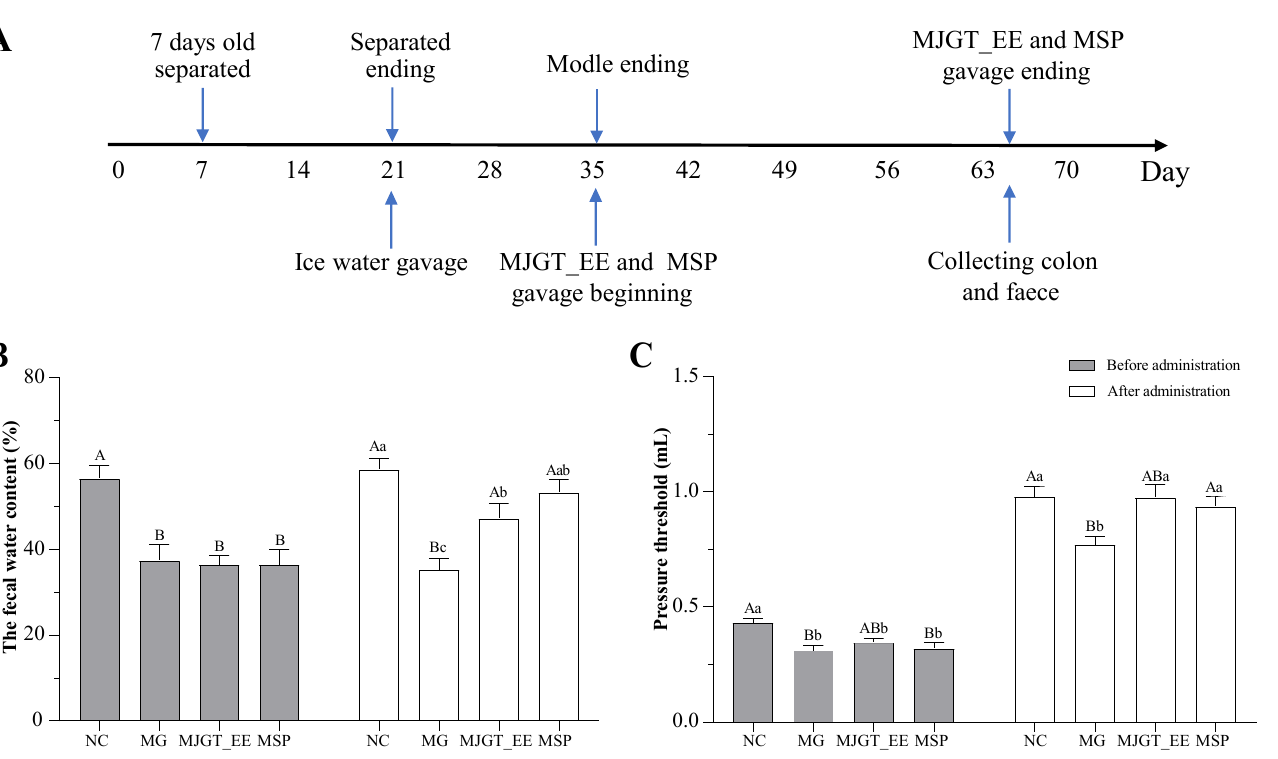
Figure 1. The timeline from rat model establishment, administration to sampling ( A ). Comparison of fecal water content ( B ) and pressure threshold ( C ) in rats of different groups. Capital and lowercase letters above the bar indicate the difference significance at the 0.01 or 0.05 levels, respectively. ( n = 8 for each group). NC: negative control group; MG: model group, MSP: mosapride group, MJGT_EE: Mao Jian Green Tea ethanol extract